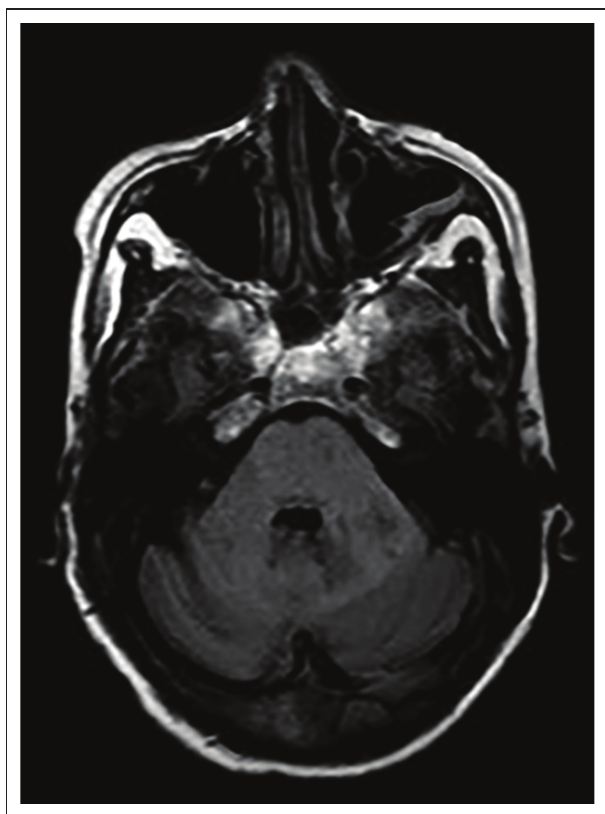
FIGURE 1: Axial FLAIR image of the patient discussed in Case 1, at the level of the pons demonstrating high-signal in the entire pons and part of the left cerebellar hemisphere. Images at a lower level (not shown) demonstrated more extensive involvement of the left cerebellum.